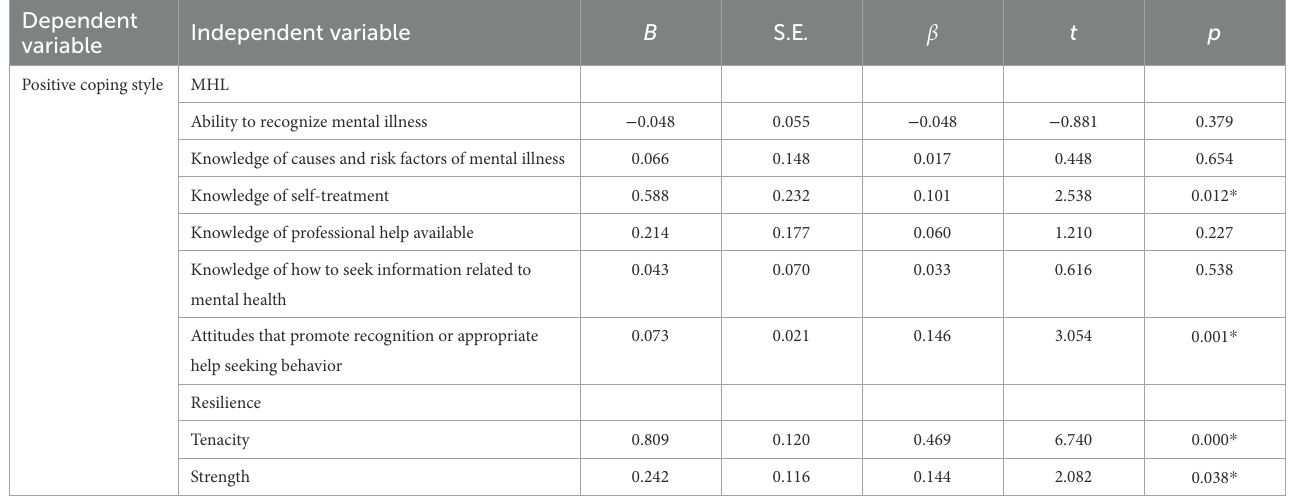
TABLE 4 The effects of MHL and resilience on positive coping style. Dependent